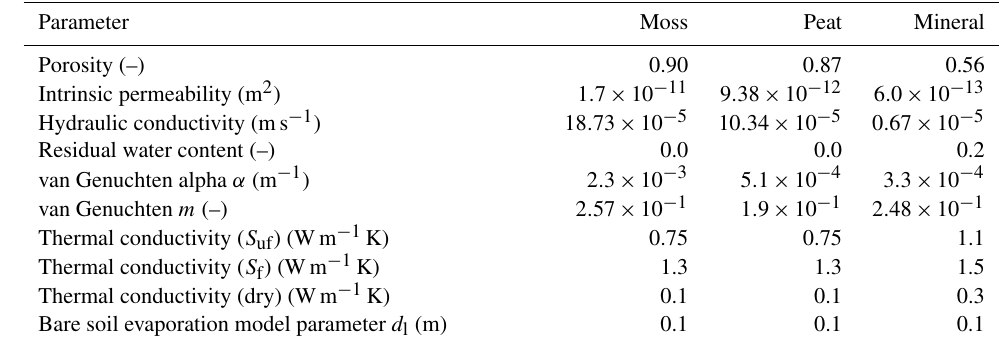
Table 2. Subsurface physical properties used in the model. Notations S uf and S f denote saturated unfrozen and frozen. Note ATS takes intrinsic permeability as input instead of hydraulic conductivity because hydraulic conductivity is temperature dependent. For reference, we also include hydraulic conductivity at 25 ◦